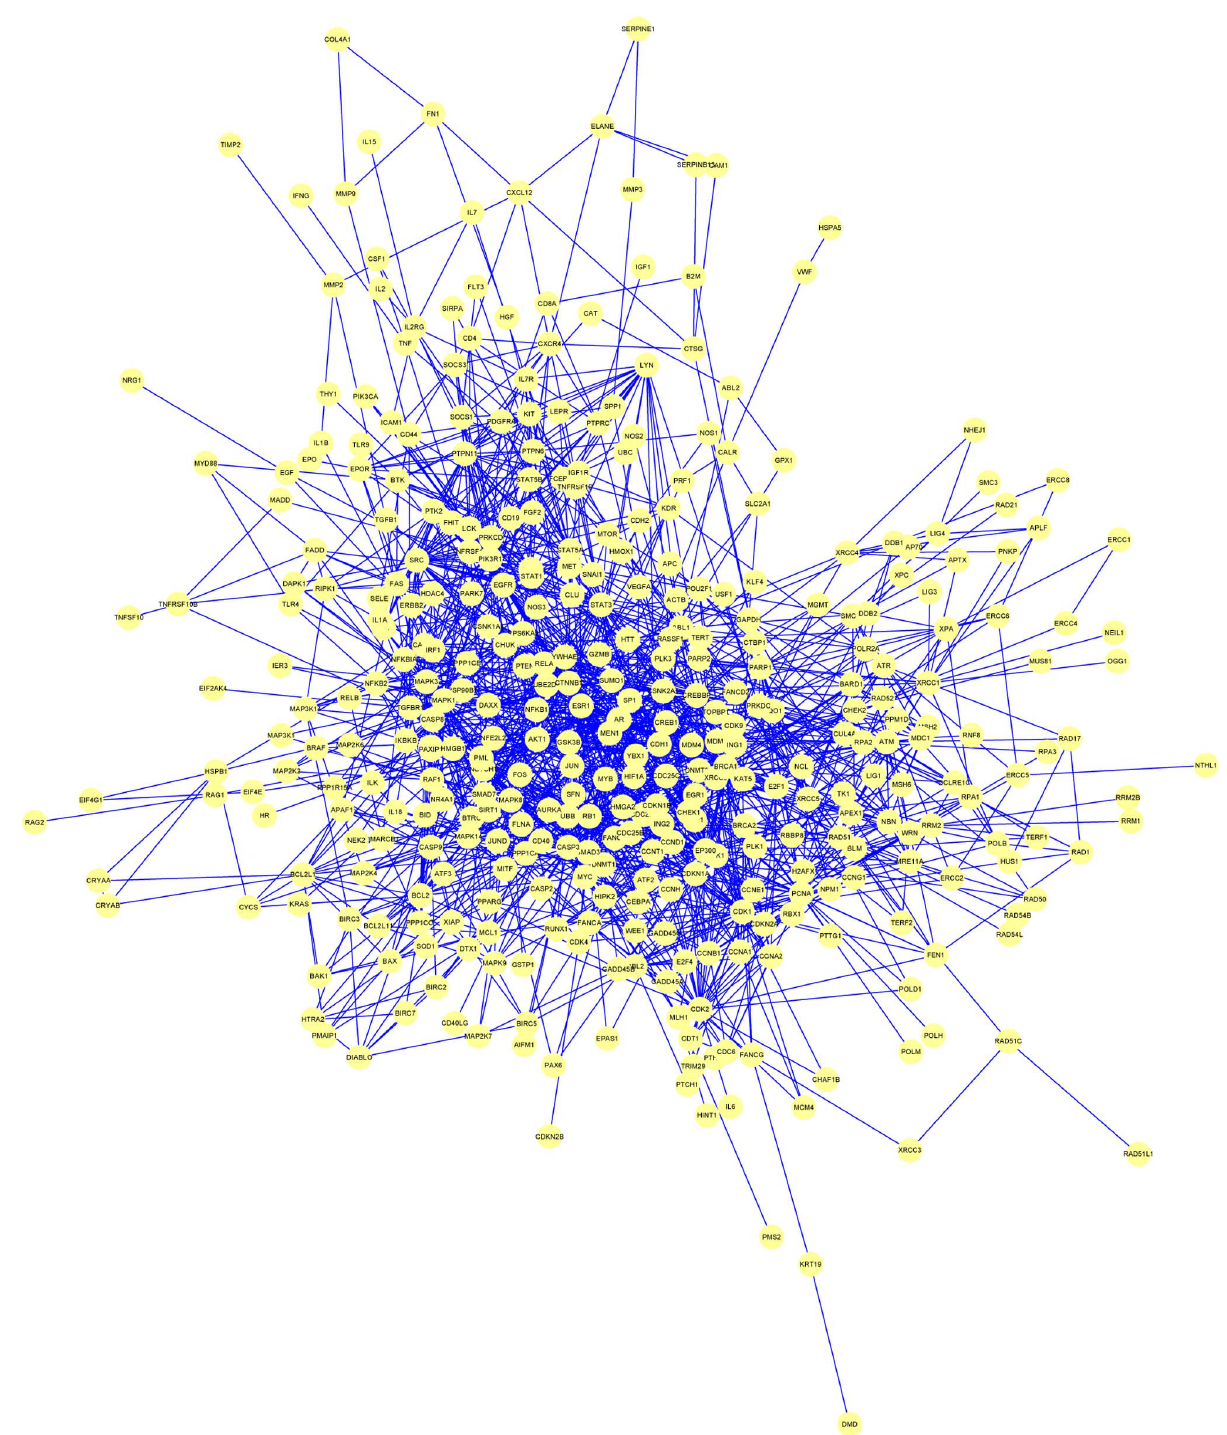
Figure 1. A PPI network of the proteins encoded by radiation-sensitive genes in mouse, rat, and human, reproduced from [ 89 ] . Yellow nodes represent the proteins and blue lines show the interactions between them. The radiation-related genes were text-mined from PubMed and the protein interaction information was obtained from HPRD.